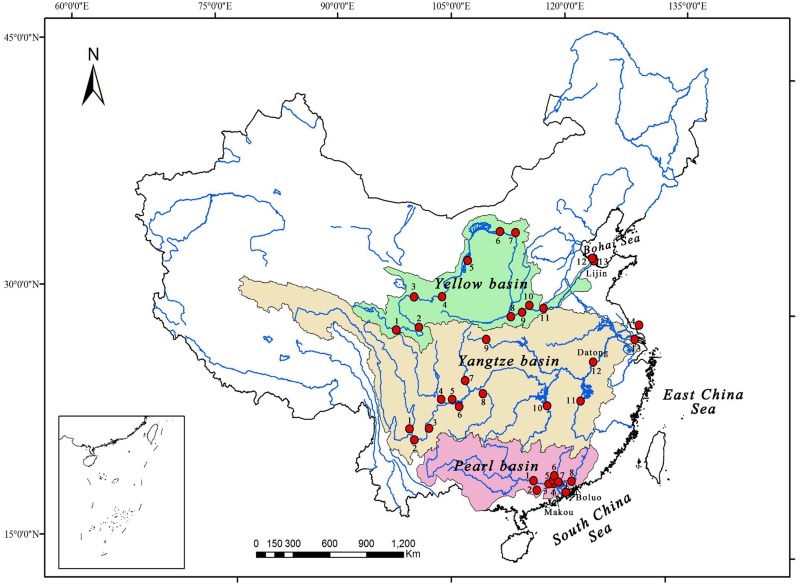
Spatial distribution of DOC from the three river basins in China.The different background colours represent the Yellow, Yangtze and Pearl River basins, respectively. Red solid circle represents the location of the sampling stations in the three river basins. The description of the serial number of each site used in this analysis can be found in the S2 Table.